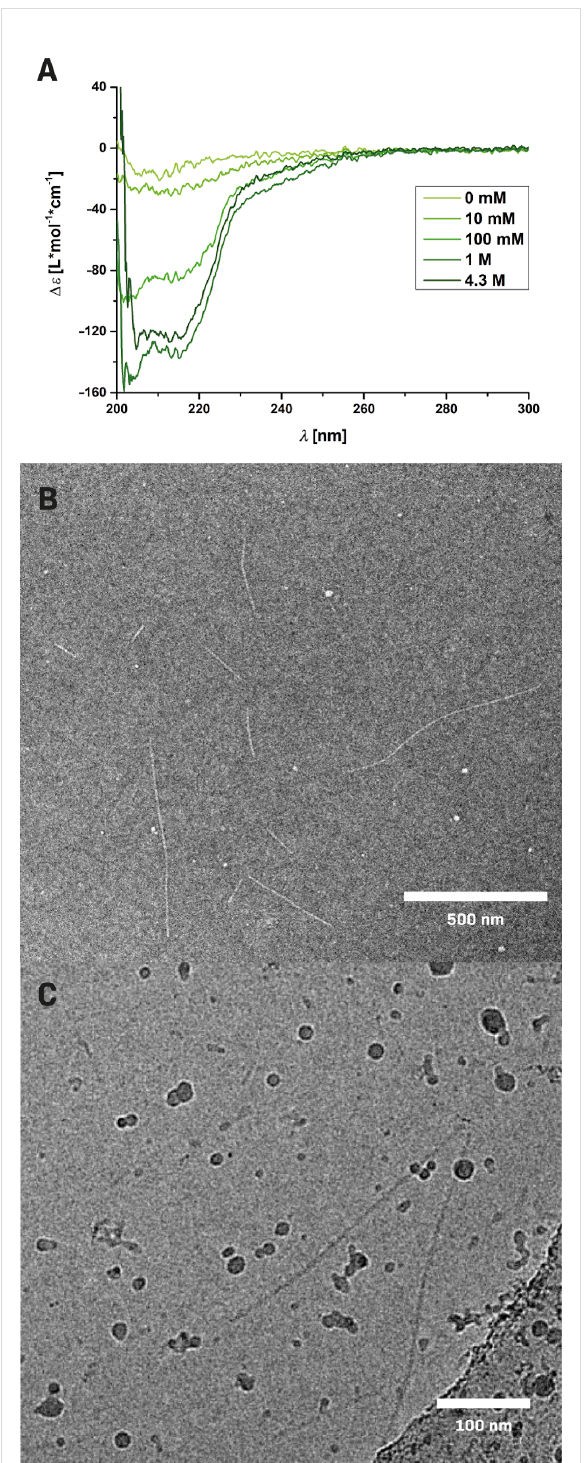
Figure 2: Analysis of the supramolecular polymerization of II by A: CD-spectra of a 25 µM solution in TRIS buffer (20 mM, pH 7.4) con- taining different concentrations of NaCl; B: TEM micrograph of a nega- tively stained 25 µM solution in TRIS buffer (20 mM, pH 7.4) contain- ing 100 mM NaCl; C: Cryo-TEM micrograph of a 50 µM solutions in PBS buffer ( − / − ), pH 7.4 containing 100 mM